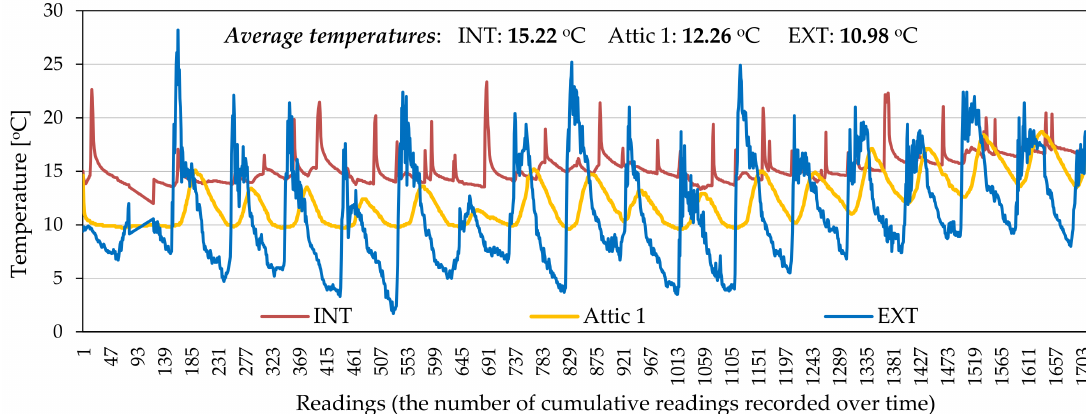
Figure 10. Global temperature profile in Attic 1.